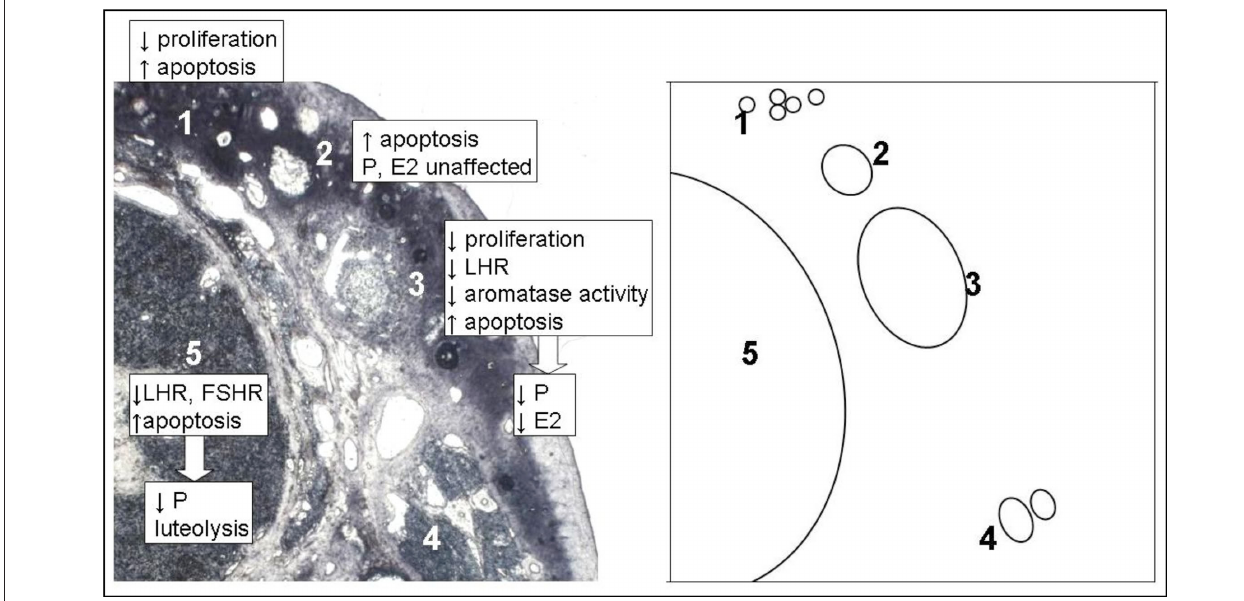
expression (Hsueh et al., 1980) while continuing to increase granulosa cell apoptosis (Takekida et al., 2003). All of these factors contribute to a significant contributing factor to luteolysis. The diagram on the right is a representation of the photomicrograph on left, showing the relative location of each follicular stage for